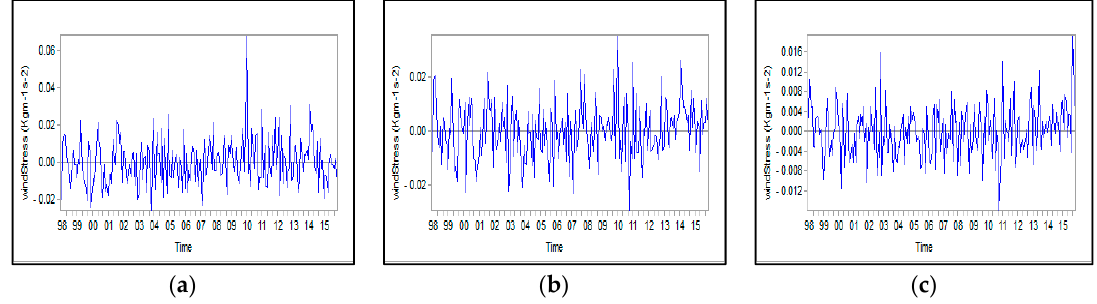
Figure A7. Monthly anomalies of wind stress for: ( a ) Northern, ( b ) Middle, and ( c ) Southern Caspian Sea.